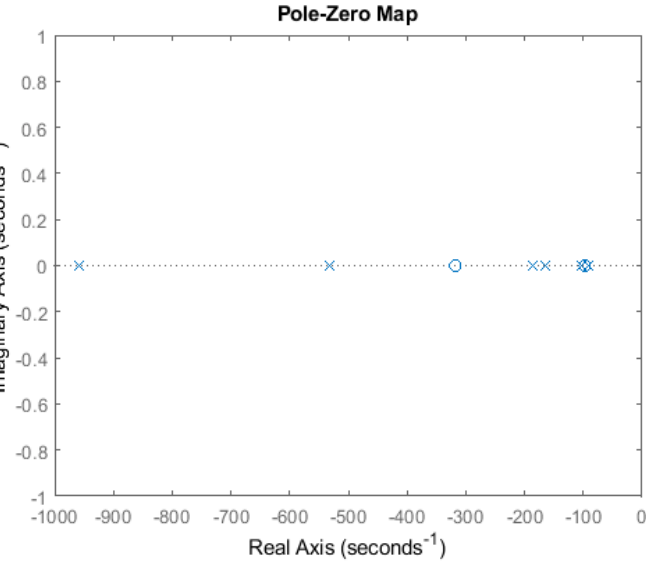
Figure 7. Frequency response of the system L(s) in vertical plane y .